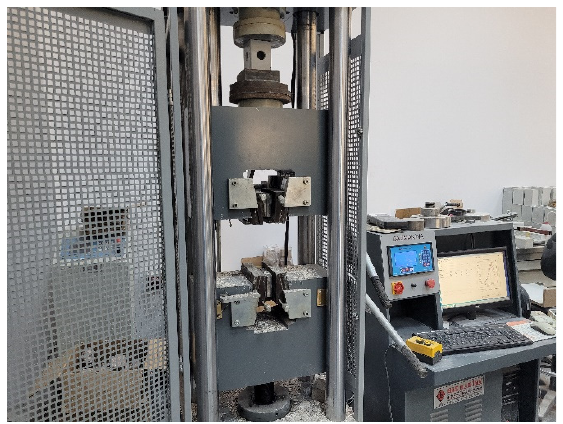
Figure 3. Test setup.